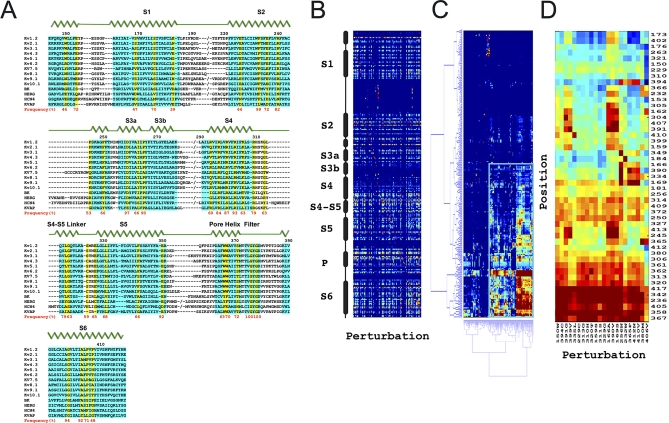
Statistical Coupling Analysis of the Kv Family(A) A representative alignment of Kv subfamilies out of the full sequence alignment of the Kv family that was used for the analysis. The sequences include Kv 1.2 (NCBI Entrez Protein Database [http://www.ncbi.nlm.nih.gov/sites/entrez?db=protein] GI: 52000923), Kv 2.1 (GI: 47523520), Kv 3.1 (GI: 5817540), Kv 4.3 (GI: 2935434), Kv 5.1 (GI: 20070166), Kv 6.2 (GI: 82997534), Kv 7.5 (GI: 8132997), Kv 8.1 (GI: 20381121), Kv 9.1 (GI: 112821679), Kv 10.1 (GI: 22164088), BK (GI: 157776), HERG (GI: 4557729), HCN (GI: 5734516), KvAP (GI:14601099). Conserved residues that were used to guide the alignment are highlighted in yellow, and their degrees of conservation are shown as frequency (%) in red (the frequency of the most common amino acid at the indicated position in the full sequence alignment) at the bottom of the alignment. The residue number corresponds to that of Kv 1.2.(B) A matrix representation of all pair-wise coupling values (termed ΔΔGstat [14]) for 95 perturbations. The column and row show positions and perturbations from N to C terminus, respectively. The coupling values range from 0.5 kT* (blue) to 2 kT* (red) in units of “statistical energy” [12].(C) Two-dimensional clustering of the matrix shows a group of positions and perturbations that are clustered together by the similarity of coupling patterns.(D) Focused clustering of an initially clustered group (box in (C)) reveals the final cluster of 49 residues and 22 perturbations.